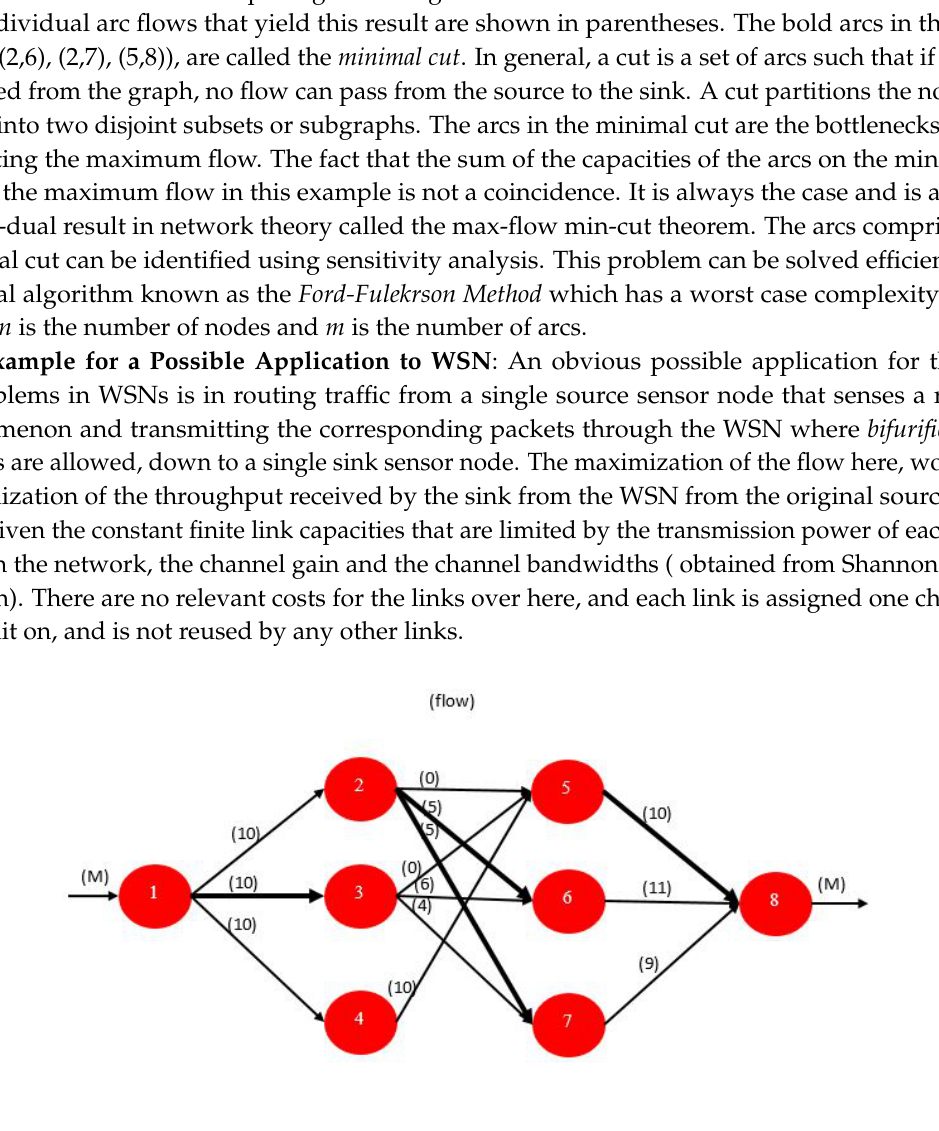
Figure 8. Maximum flow (minimal cut) =